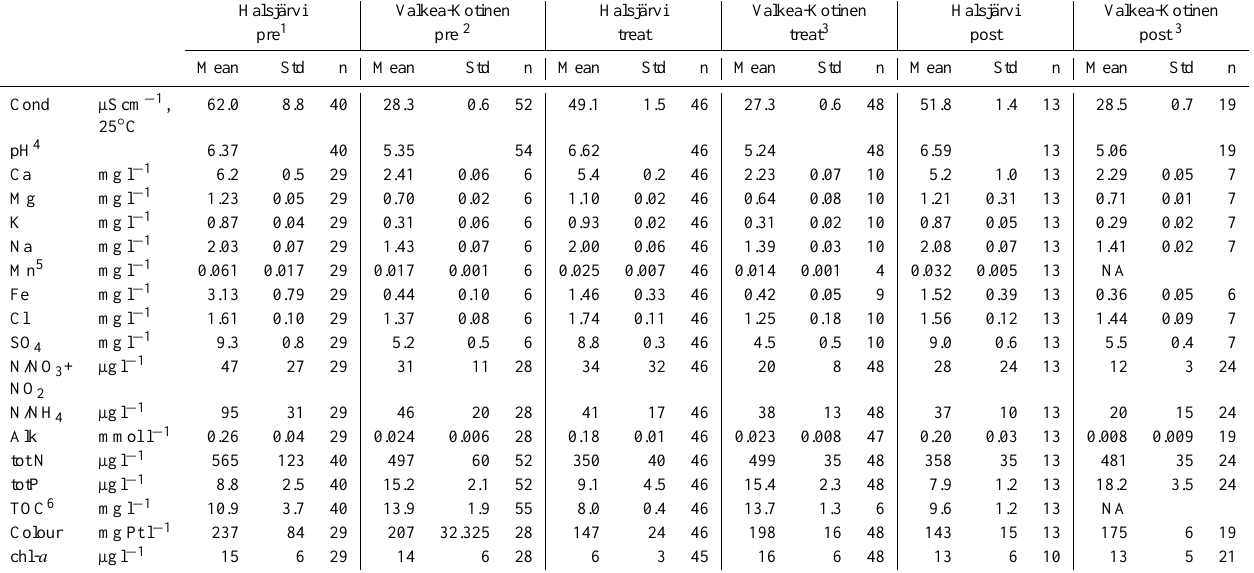
Table 2. Chemical characteristics of lakes Halsj¨arvi (experimental lake) and Valkea-Kotinen (reference lake). Values are whole-lake volume- weighted mean concentrations and standard deviation based on samples collected during the ice-free season in May to October each year. Pre-treatment (pre) 2003–2004; treatment 2005–2006 (treat); post-treatment 2007 (post).